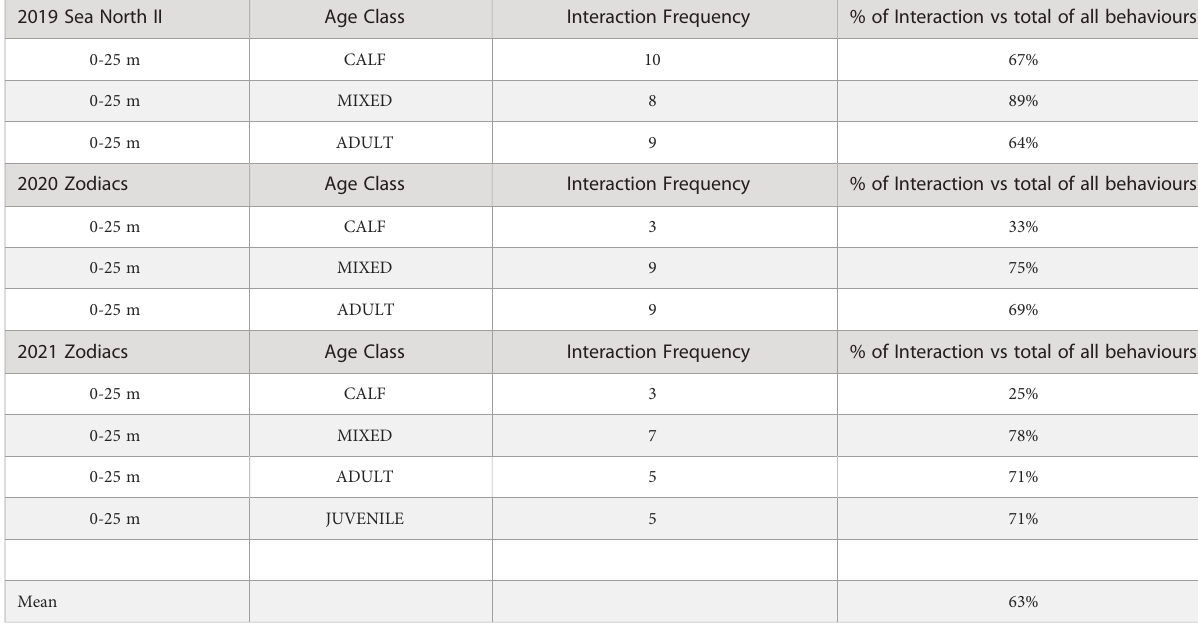
TABLE 10 Frequency of beluga interactions with whale-watching vessels by year and age